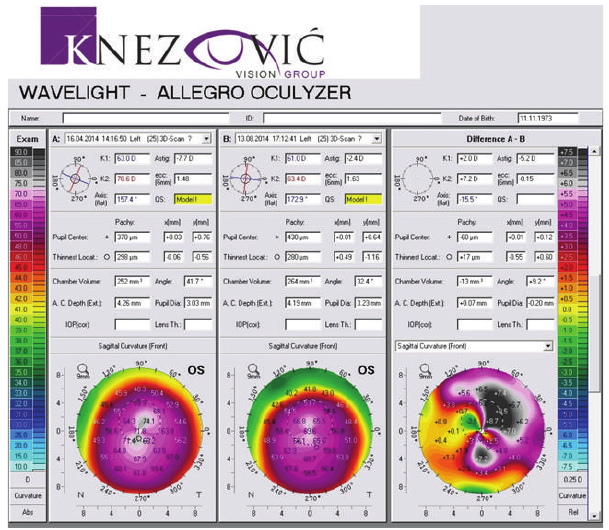
Figure9:Pre-andpostoperativeScheimpflugtomography(anterior sagittal curvature map), right eye.